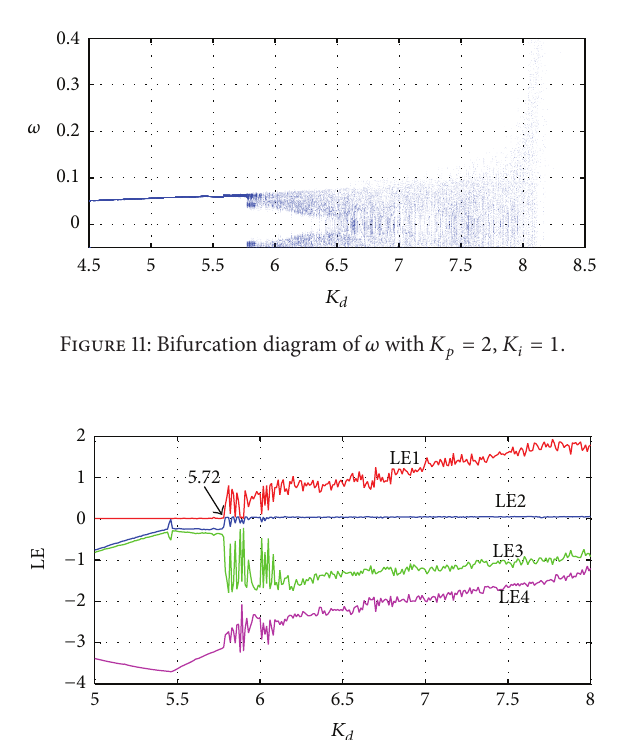
Figure 12: Lyapunov exponent with 𝐾 𝑑 .